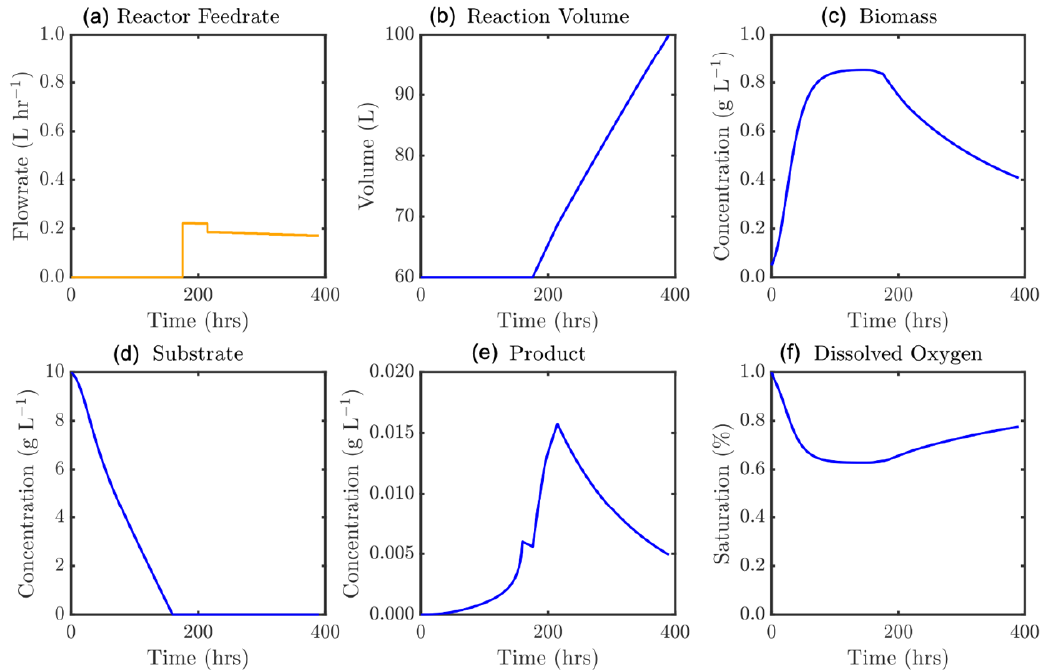
Figure 15. Optimal feedrate profile ( a ) and corresponding model states, ε = 390 h: ( b ) culture volume, and concentrations of ( c ) biomass, ( d ) substrate, ( e ) product, and ( f ) dissolved oxygen.